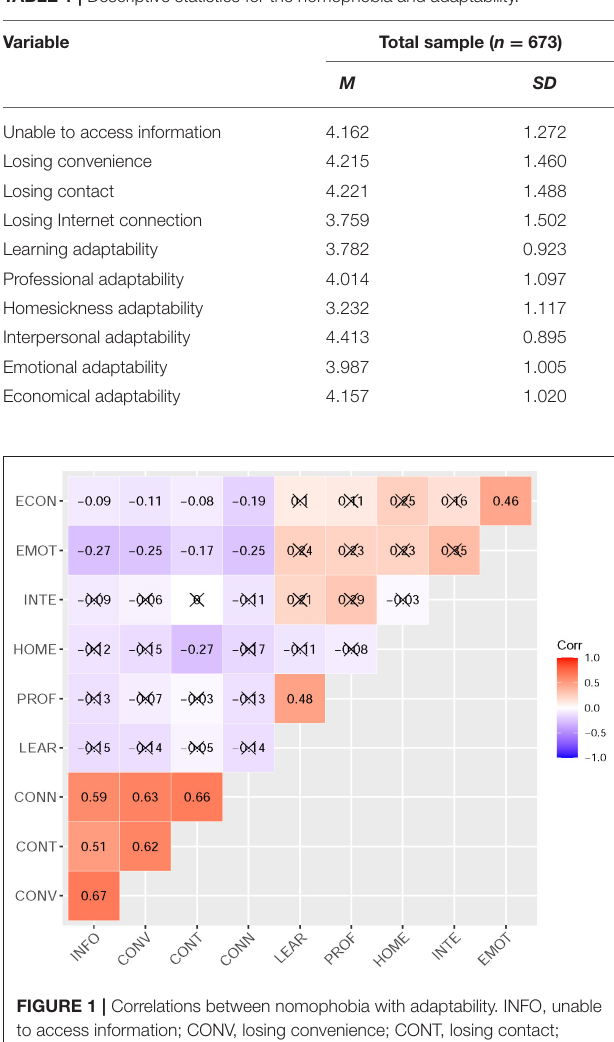
emotional adaptability showed M = 3.987, SD = 1.005, and economical adaptability showed M = 4.157, SD =